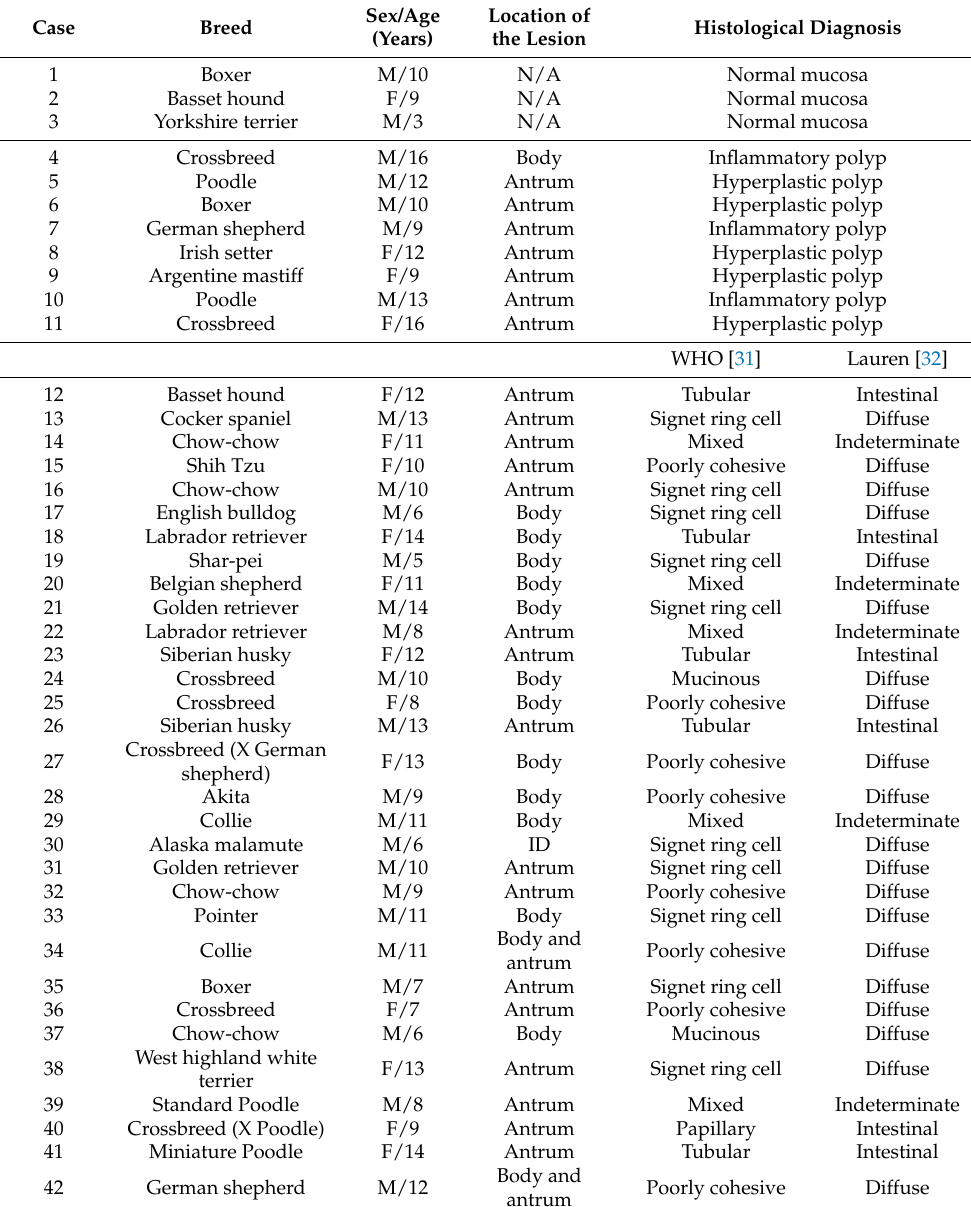
Table 1. Animal epidemiological data (breed, age, sex) and characteristics of the specimens included in the present